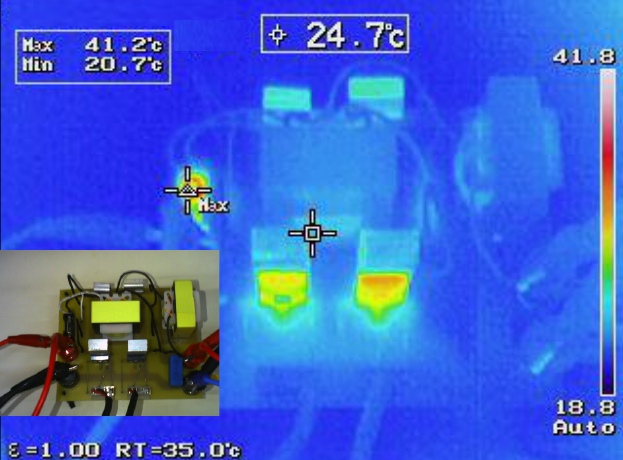
Figure 15. Infrared image of the converter at full